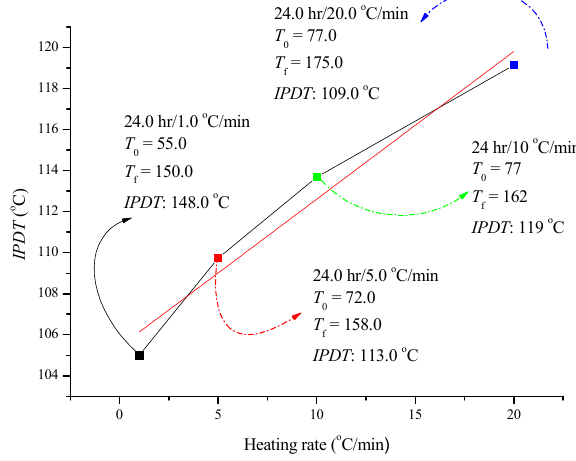
Figure 6. Linear dependence of IPDT for ADVN at 24 h UV at heating rates of 1, 5, 10, and 20 °C/min. Table 2. Reaction kinetic simulation for ADVN with UV/24 h using non-linear regression methods at heating rates of 1, 2, 4, and 8 °C/min.